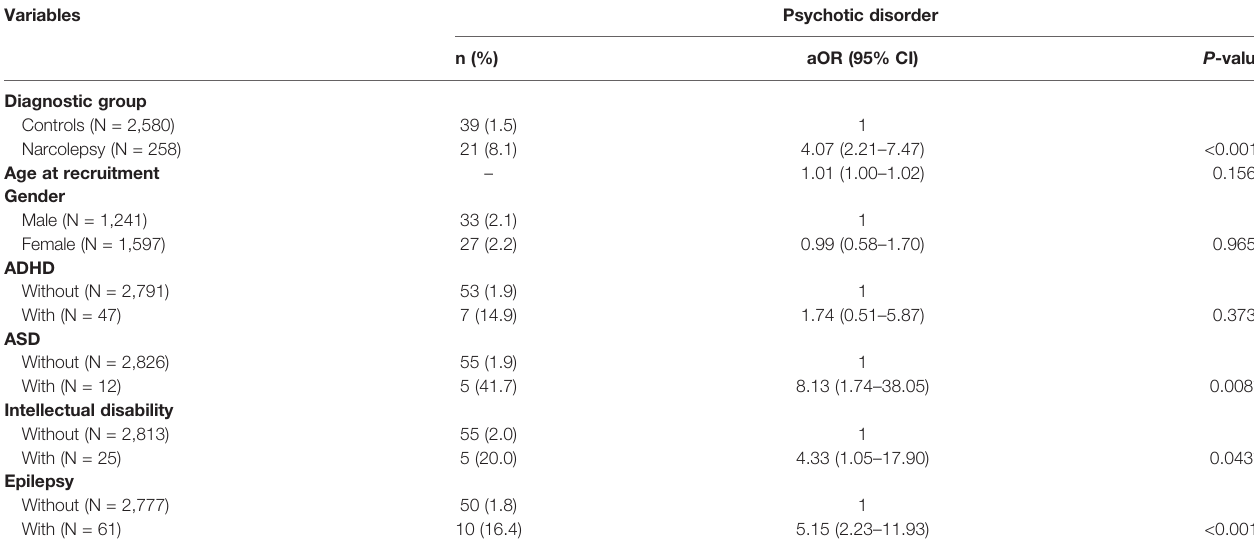
TABLE 2 | Logistic regression models for the risk of diagnosis with a psychotic disorder among all participants, controlling for gender, age, and comorbidities.